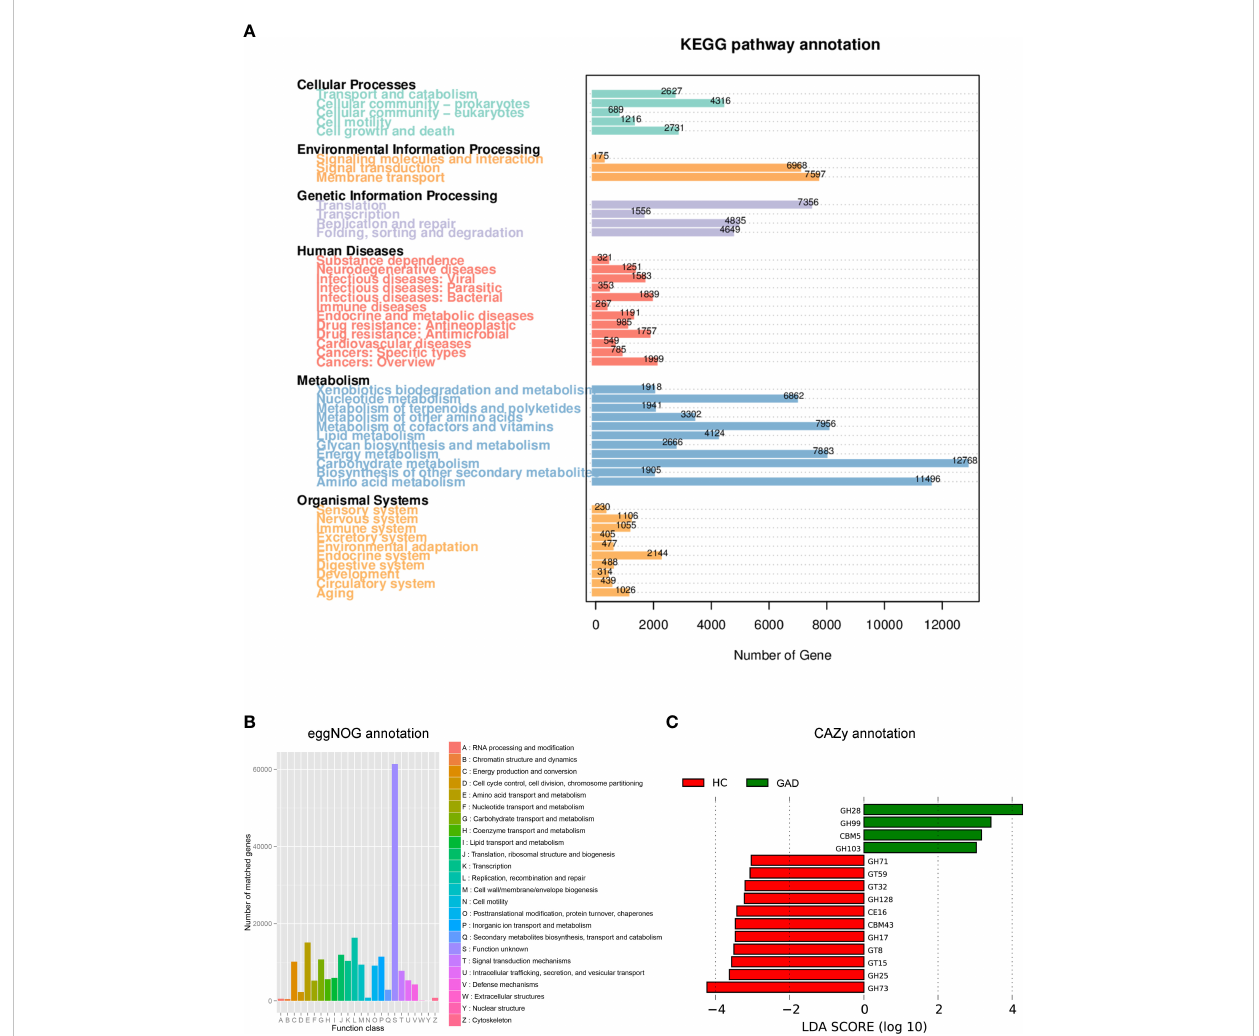
FIGURE 4 Functional predictions for the ear canal microbiome of patients with GAD. (A) Different abundance levels of genes annotated according to functional classi fi cation based on Kyoto Encyclopedia of Genes and Genomes (KEGG) databases. (B) Different abundance levels of genes annotated according to functional classi fi cation based on evolutionary genealogy of genes: non-supervised orthologous groups (eggNOG) database. (C) LEfSe analysis revealed signi fi cant predicted function based on alignment with Carbohydrate-Active enzymes (CAZy) database between the GAD (positive score) and HC groups (negative score). LDA scores (log10) > 3 and P < 0.05 are